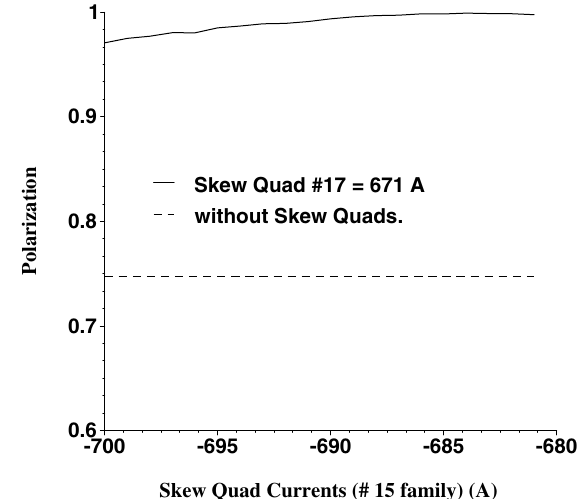
FIG. 9. Polarization after crossing the 36 (cid:1) (cid:28) with fixed normal mode tunes ( (cid:28) currents for hypothetical skew quadrupoles in the 15th straight sections. The 17th skew quadrupole family was fixed at 671 A. The dashed line indicates base polarization without any skew quadrupoles